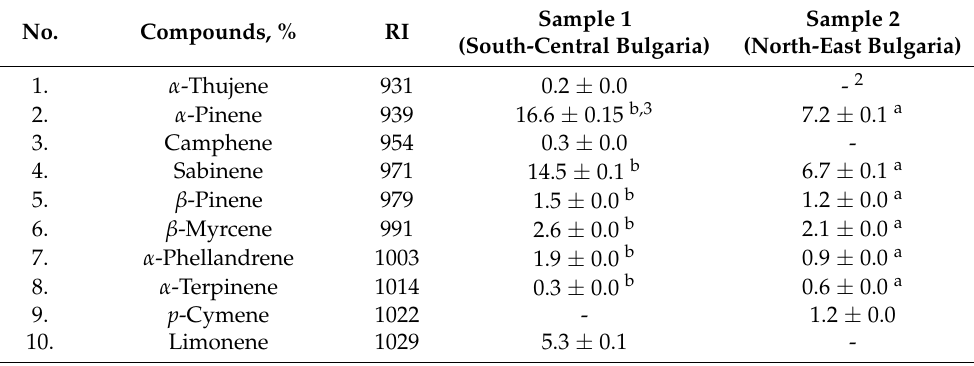
Table 2. Chemical composition of EOs of V. agnus-castus fruits 1